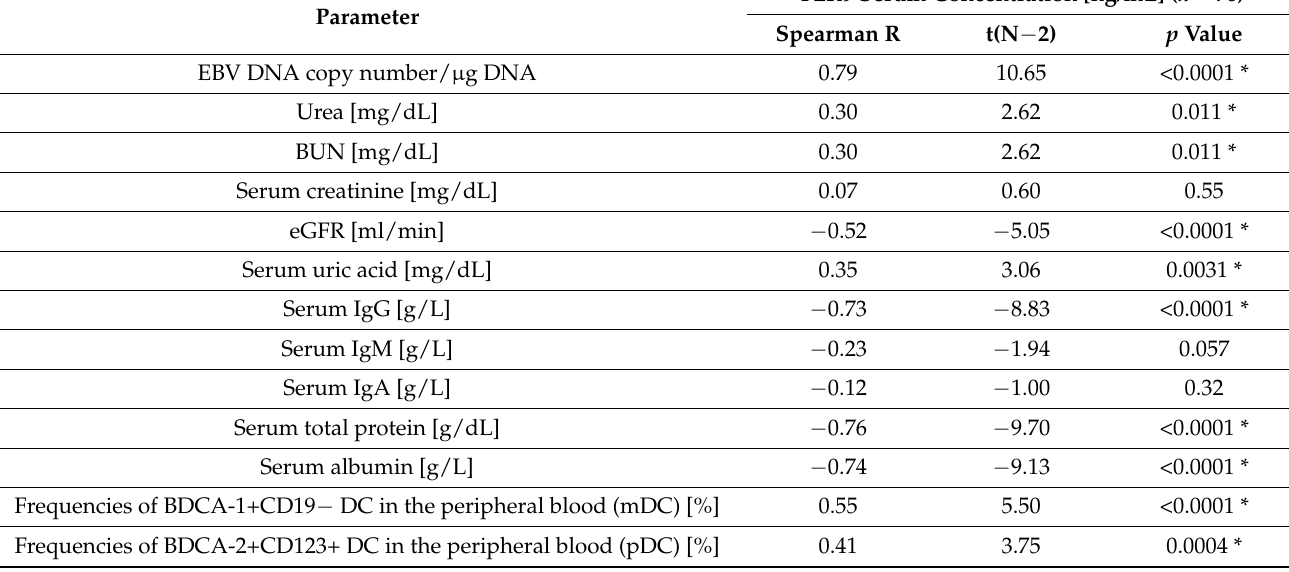
Table 5. Correlation between serum TLR9 concentration and selected biochemical and immunological parameters of the studied population.